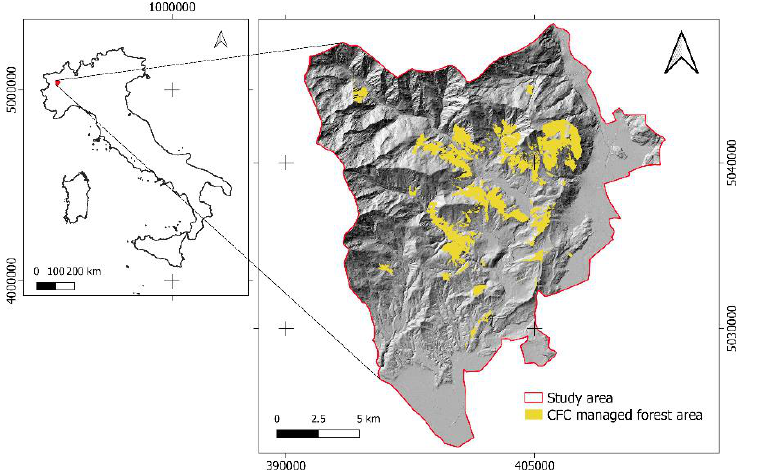
Figure 3. Study area in Italy (left). Area of Interest (AOI) where the forest plan had to be defined by CFC. In grey the hill shading of the SRTM 1 Arc-Second 30 m [80] (coordinate reference system is WGS 84/UTM zone 32 N).